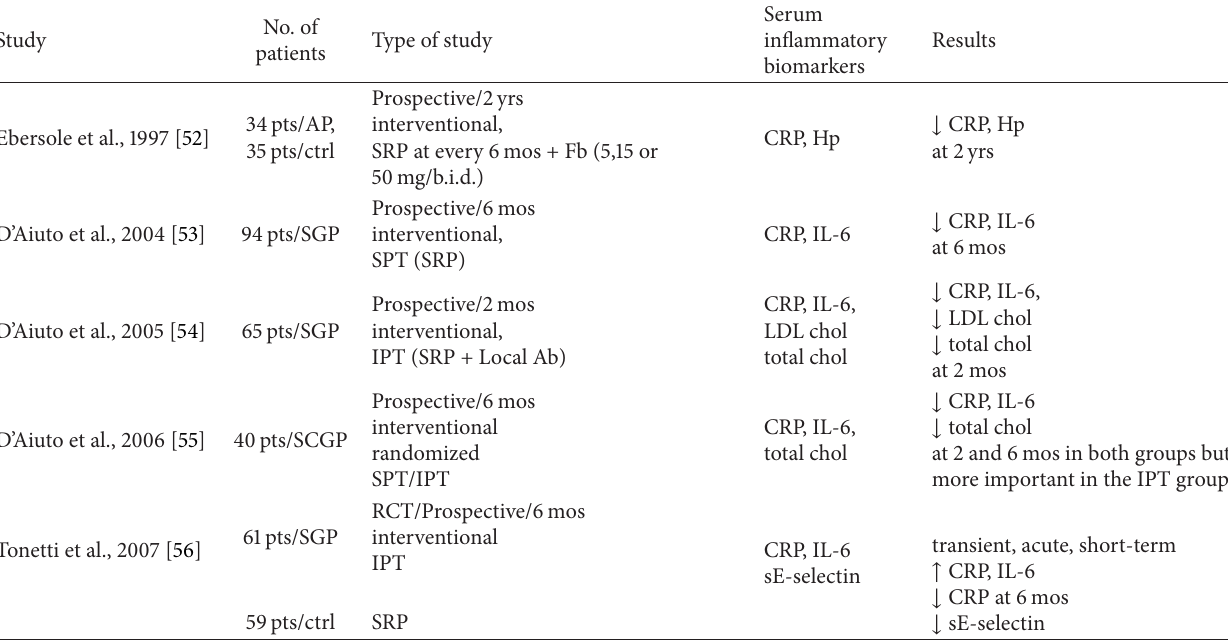
Table 1: Interventional studies (impact of periodontal therapy on systemic inflammatory biomarkers). No. of Study